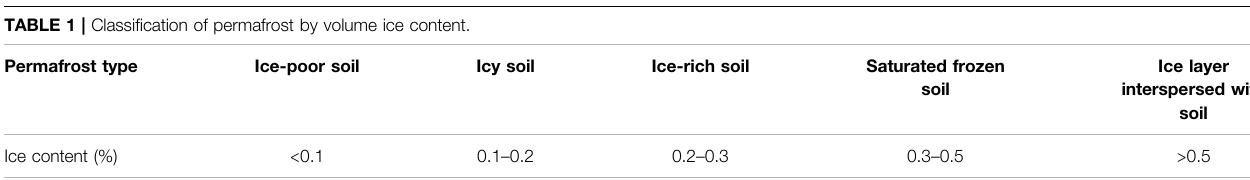
TABLE 1 | Classi fi cation of permafrost by volume ice